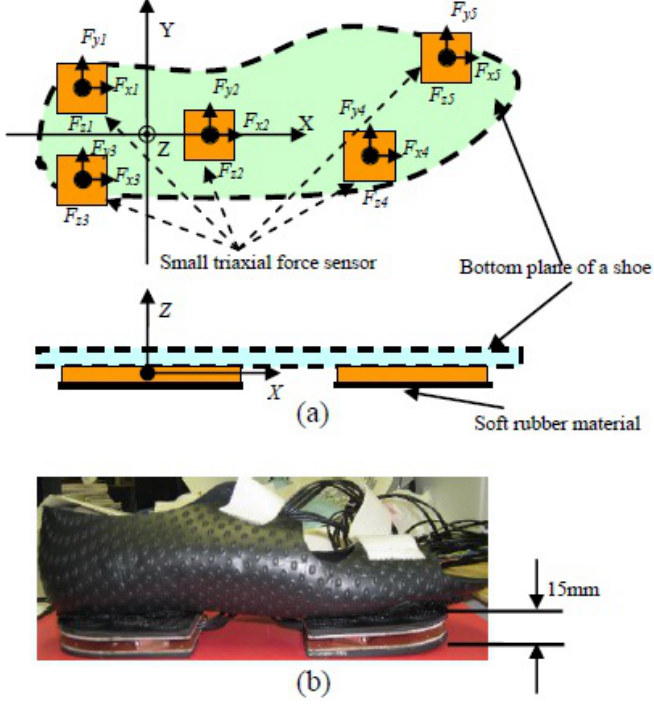
Figure 5. A wearable GRF sensor system constructed using five small triaxial force sensors. ( a ) Definition of sensors’ ordinate system and sensor mechanism; ( b ) Prototype of an instrumented shoe for right